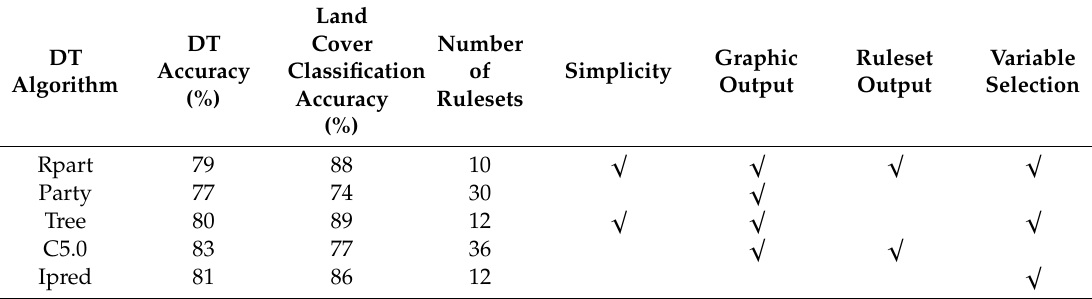
Table 6. Summary of classification accuracies and other properties of DT